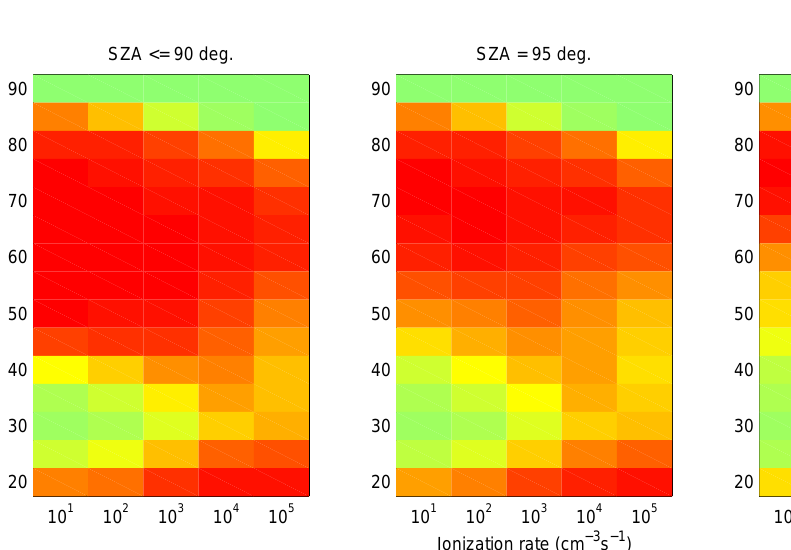
Fig. A27. P H /Q for October